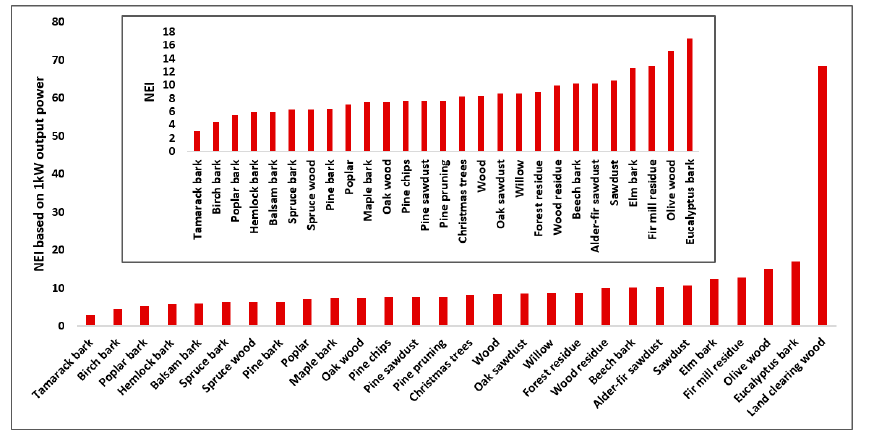
Figure 6. Environmental impact assessment of various WB&FR gasification per 1 kWh net power production.